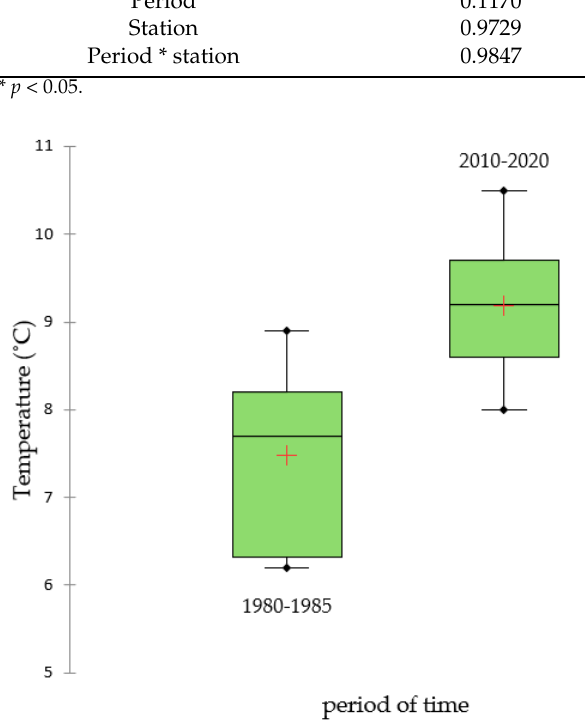
Figure 2. Box-plot of temperature in two periods of time (the averages marked with red cross).